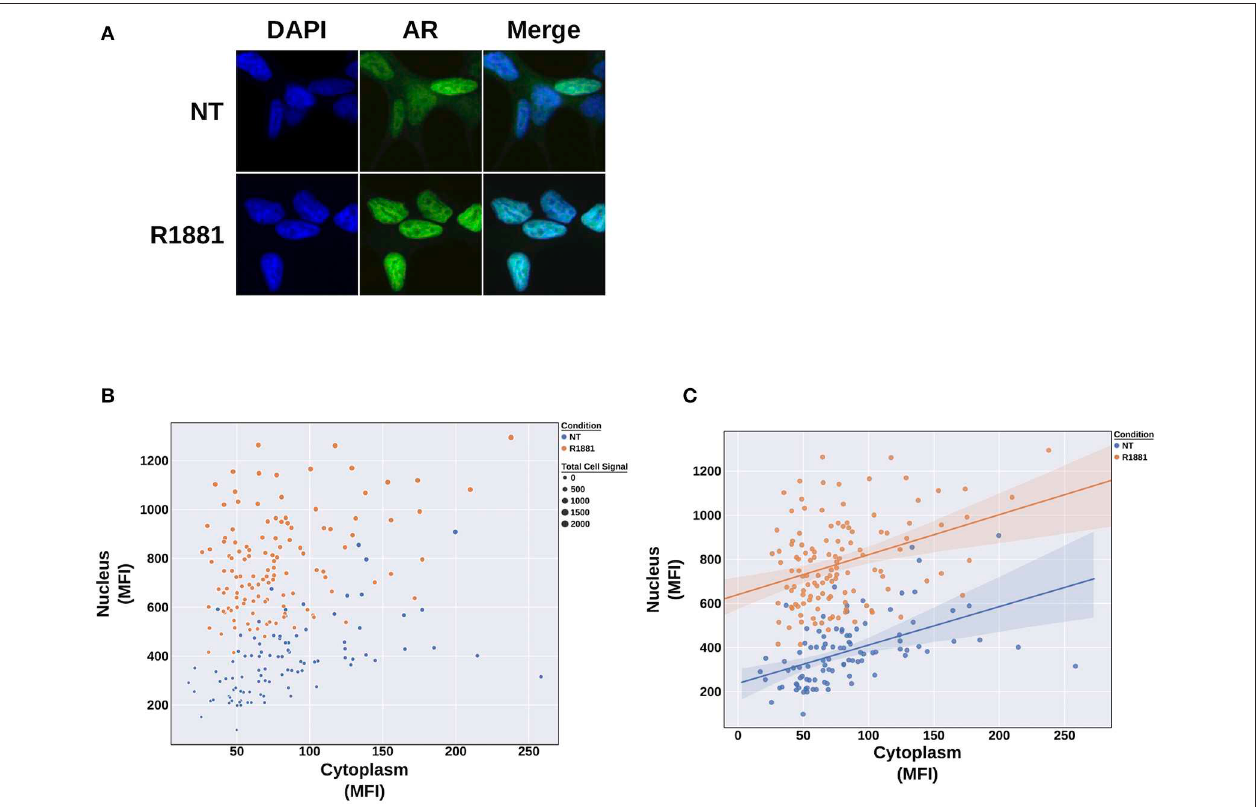
FIGURE 8 | R1881 treatment shows nuclear translocation of the androgen receptor in LNCaP cells. (A) LNCaP cells were either left non-treated or treated with 1nM R1881. Under R1881 treatment conditions, androgen receptor (AR) localization shifts from nuclear and cytoplasmic to primarily nuclear. (B) xy scatter plot of the mean fluorescence intensity (MFI) of the cytoplasm ( x ) and the nucleus ( y ). The size of the point denotes sum of the cytoplasmic and nuclear signal (i.e., total cell signal). Treating LNCaP cells with R1881 induces a shift into the nucleus and increase in signal inside the nucleus. (C) a linear regression plot depicting the clear separation of the